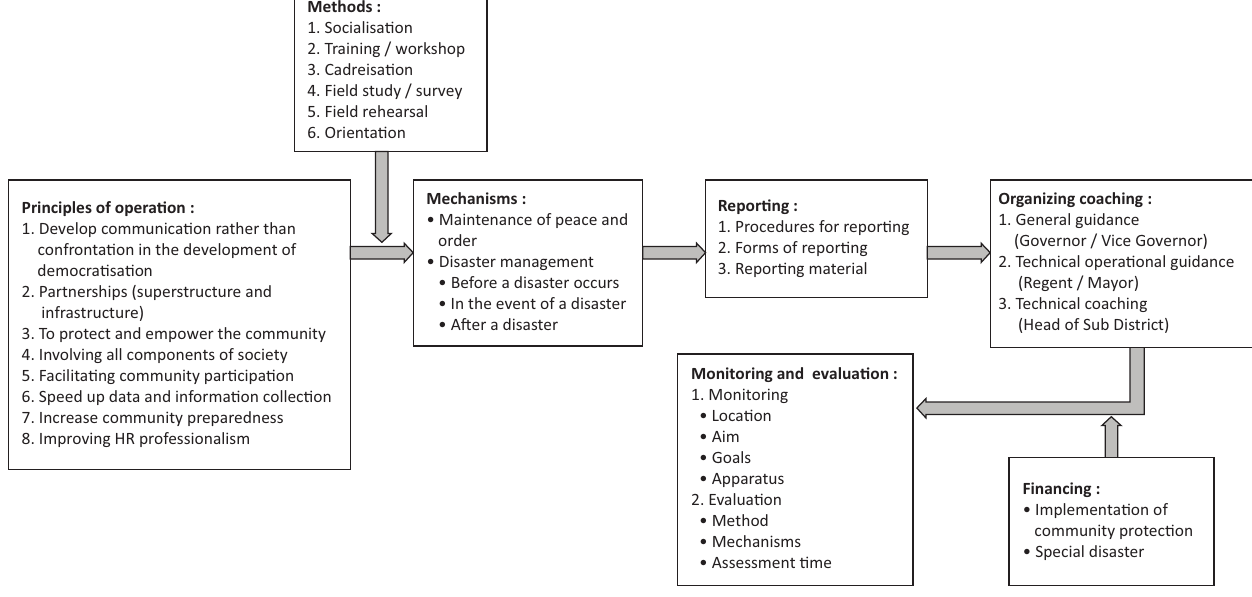
FIGURE 3: Principle and methods for the implementation of community protection in disaster management.